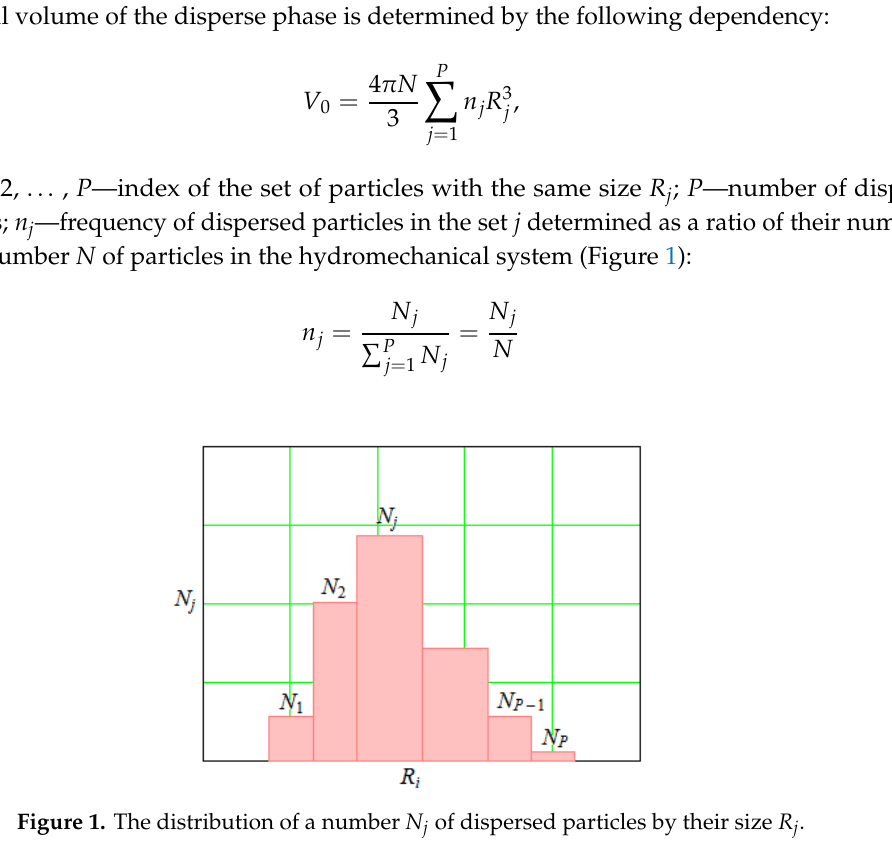
Figure 1. The distribution of a number N j of dispersed particles by their size R j .